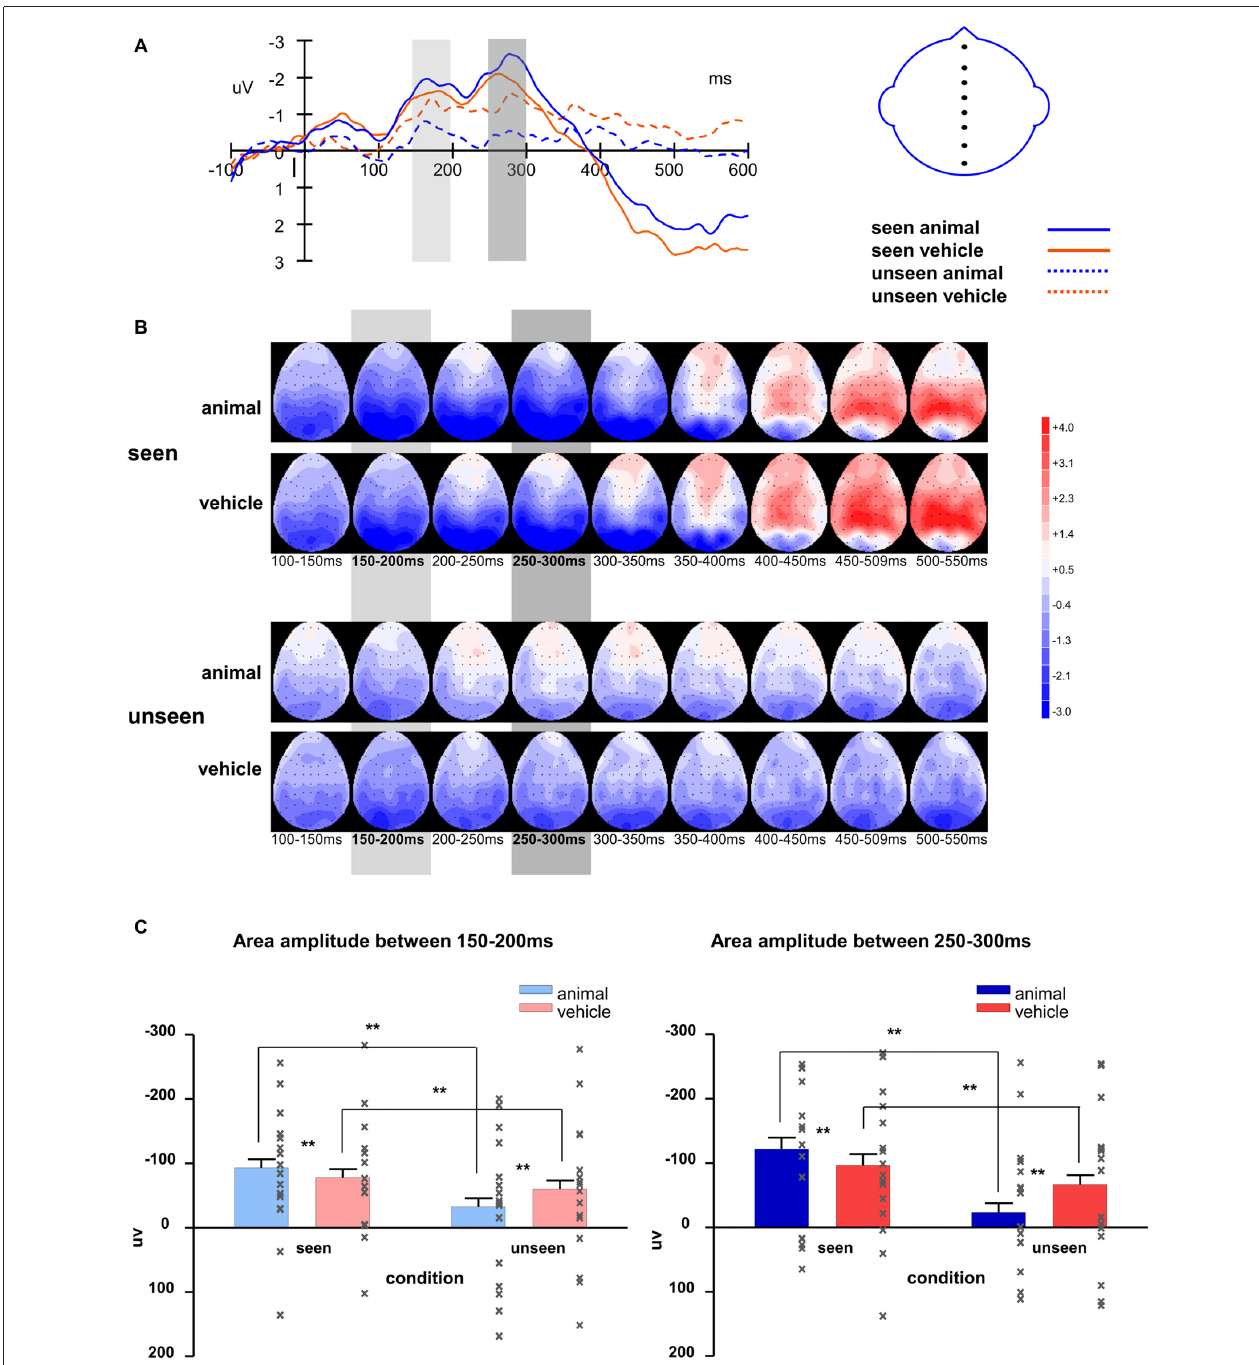
FIGURE 8 | (A) Averaged waveforms of eight midline electrodes and (B) topography for animal and vehicle stimuli in seen and unseen trials; (C) averaged area amplitude between 150–200 ms and 250–300 ms. All error bars represent 1 SEM. Asterisk markers designate statistical significance: ∗ p < 0.05, ∗∗ p < 0.01.